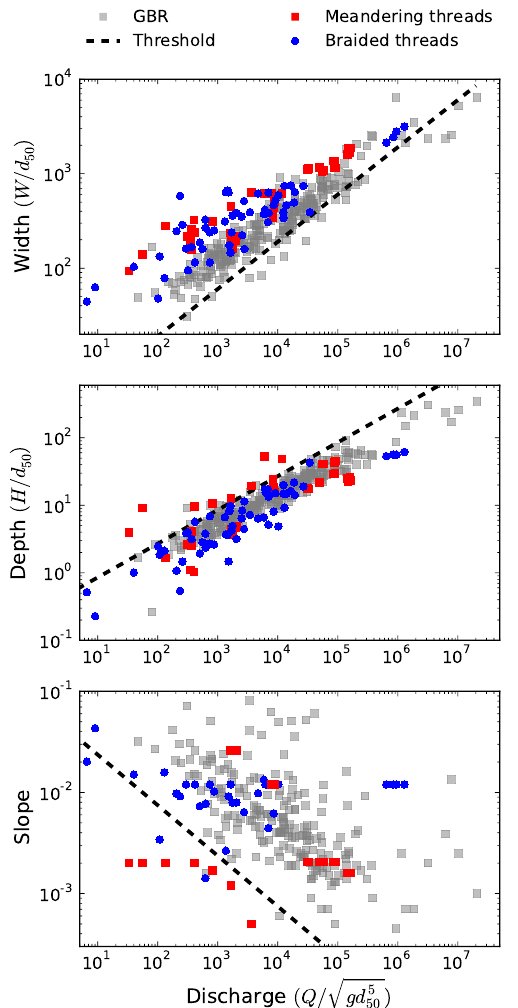
Figure 7. Dimensionless width, depth and slope of individual gravel-bed threads as a function of dimensionless water discharge. Dashed lines represent the threshold